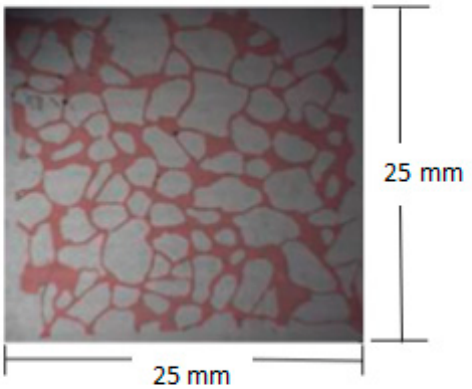
Figure 1. Image of saturated residual oil in glass etching model (25 × 25 mm).